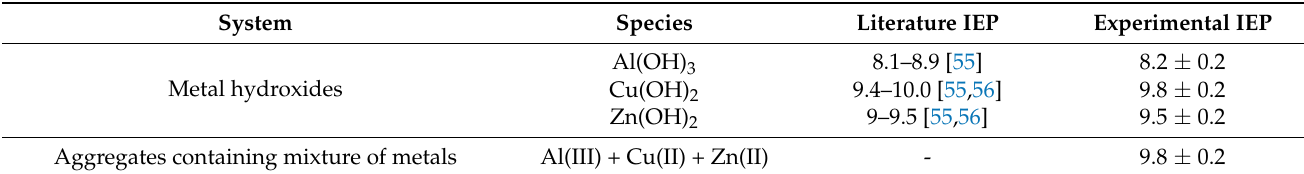
Table 2. Literature and experimental values of isoelectric points (IEPs) for investigated system. System